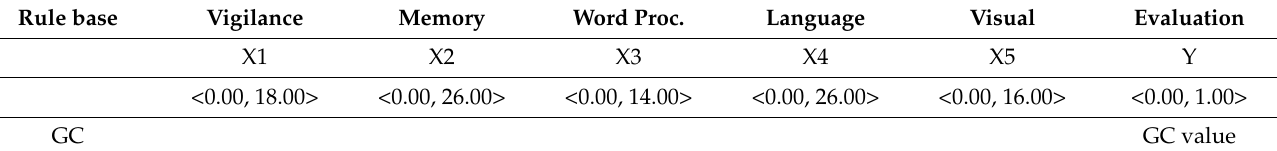
Table 7. Linguistic variables for all 9 rulebases.